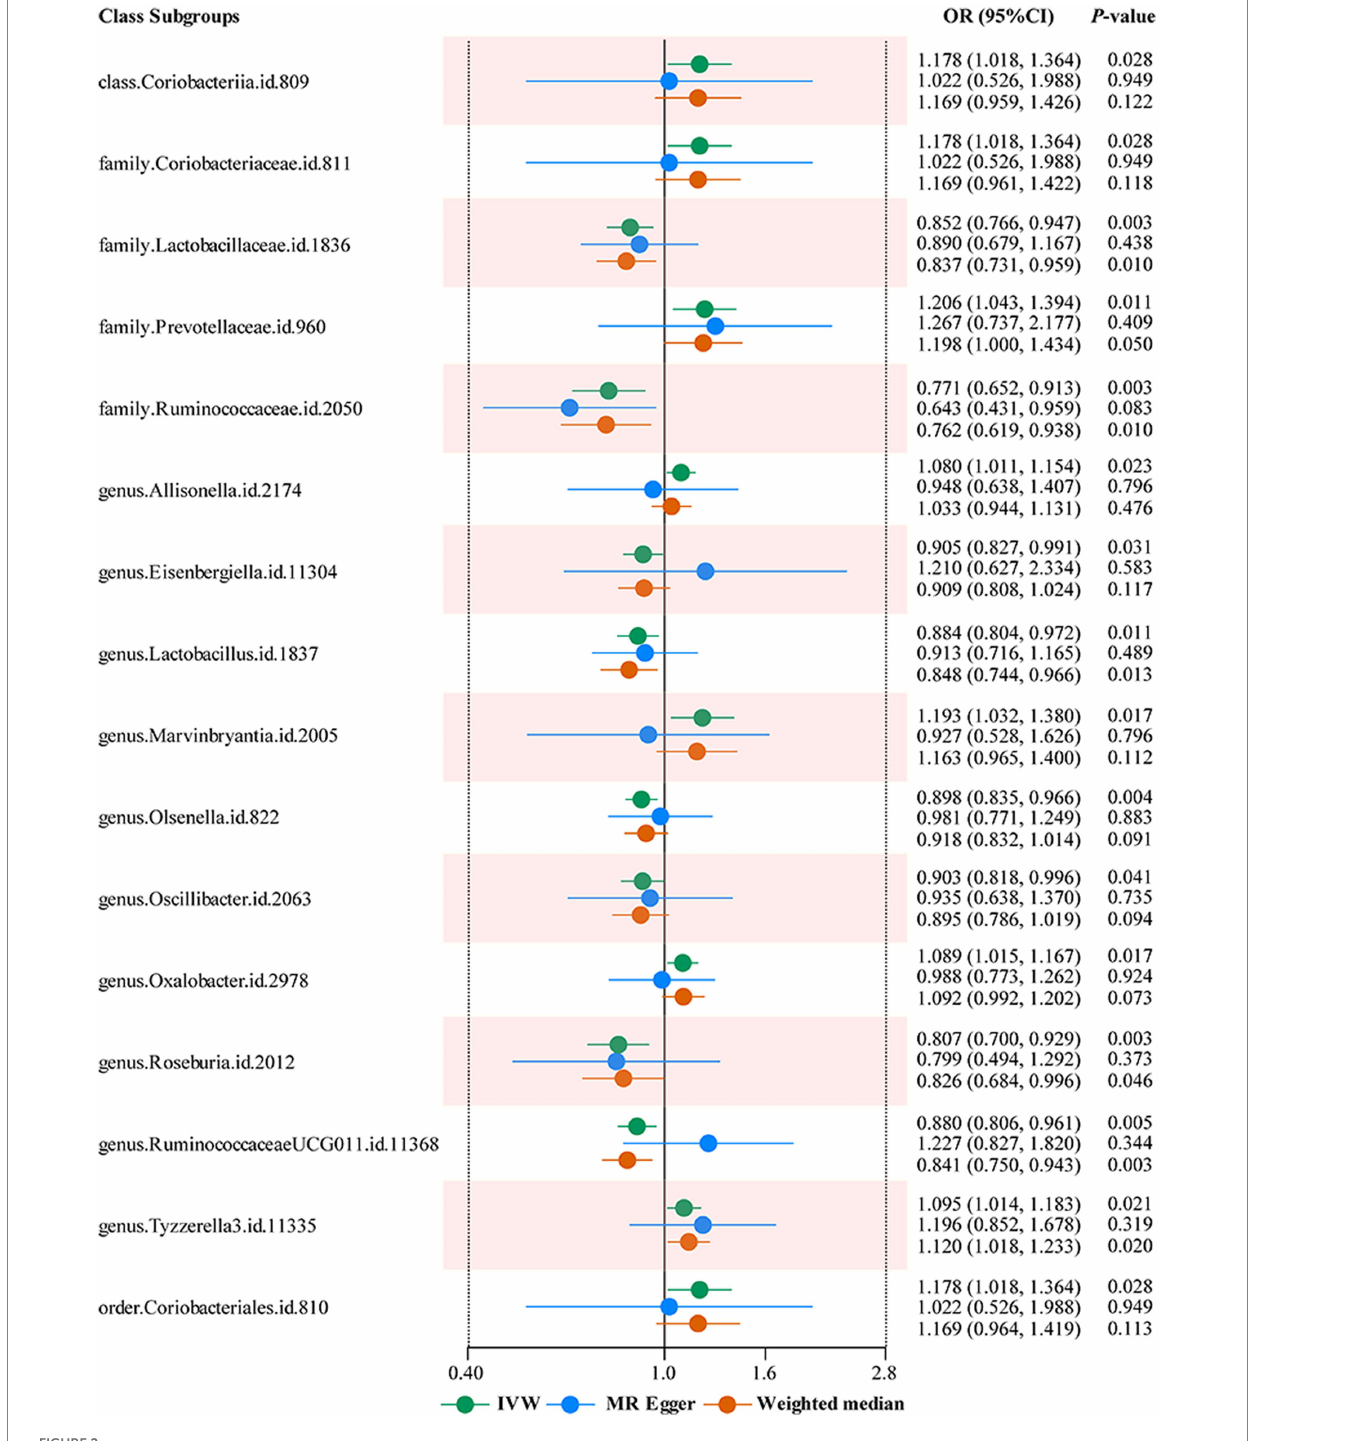
None of the MR-Egger regression intercepts deviated from zero, indicating that there was no indication of horizontal pleiotropy (all intercept p > 0.05) (Supplementary Tables 12, 13). MR-PRESSO test uncovered no evidence of horizontal pleiotropy in causal relationships ( p > 0.05) (Supplementary Table 14). Besides,